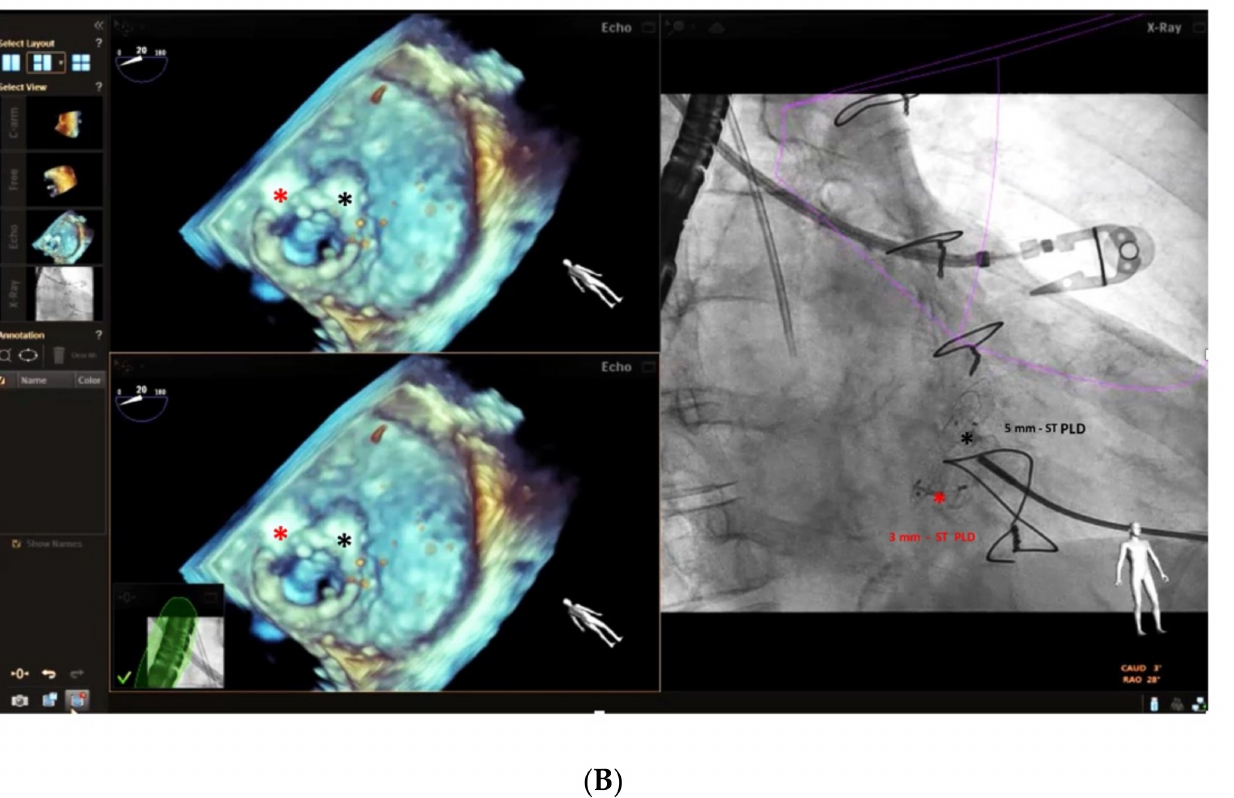
Figure 7. ( A ) Baseline 3D TEE color Doppler showing two round-shaped mitral PVLs with significant regurgitant jets located at 5 o’clock (3.2 mm) and 7 o’clock (3.6 mm) ( a , b ) in a female patient with a mitral bioprosthetic valve replacement; ( c ): successful implantation of a 3 mm-square twist PLD (red asterisk) at 5 o’clock; ( d ): fusion of real-time 2D TEE (Phillips Epiq7) and cardiac fluoroscopy imaging was obtained using EchoNavigator®-system (Philips Healthcare, Best, The Netherlands) with the fused image maintained demonstrating the location of the postero-laterally located (7 o’clock) mitral PVL (yellow circle) that was marked to aid the pathway of the guidewire (black arrow) crossing the leak, particularly in the case of a radiolucent bioprosthetic valve like in our patient. “*” refers to 3 mm-square twist PLD. ( B ) Intraprocedural navigation using fusion of 3D TEE and fluoroscopy with the fused image maintained helped the interventionalist to close successfully the second leak with a 5 mm-square twist PLD (black asterisk), improving the safety and the efficacy of this technically challenging procedure. PLD, Occlutech Paravalvular Leak Device ST, square twist, “ * ” refers to 5 mm-square twist